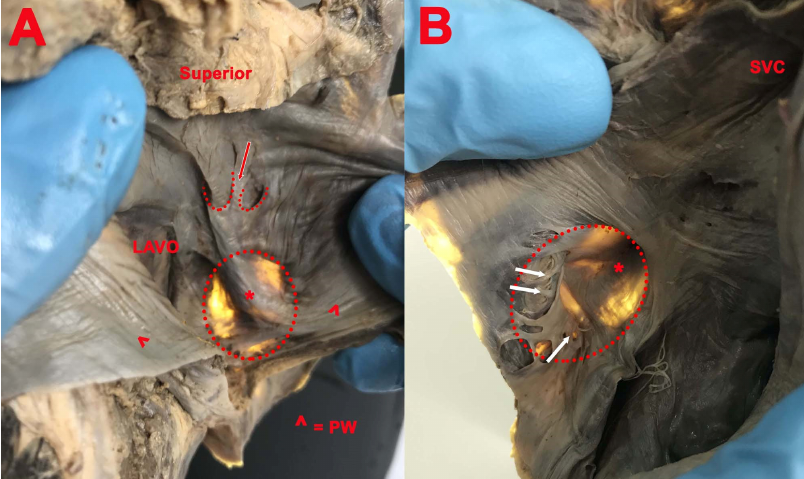
Figure 2. ( A ): Double SP with superior concavity; common fibro-muscular bundle (red arrow); * —right and left image of the prominent ridge along FO; LAVO —left atrioventricular orifice; PW — posterior wall. ( B ): SP in the superior part of the limbus; net-like structure in the opposite part of SP (white arrows); SVC —superior vena